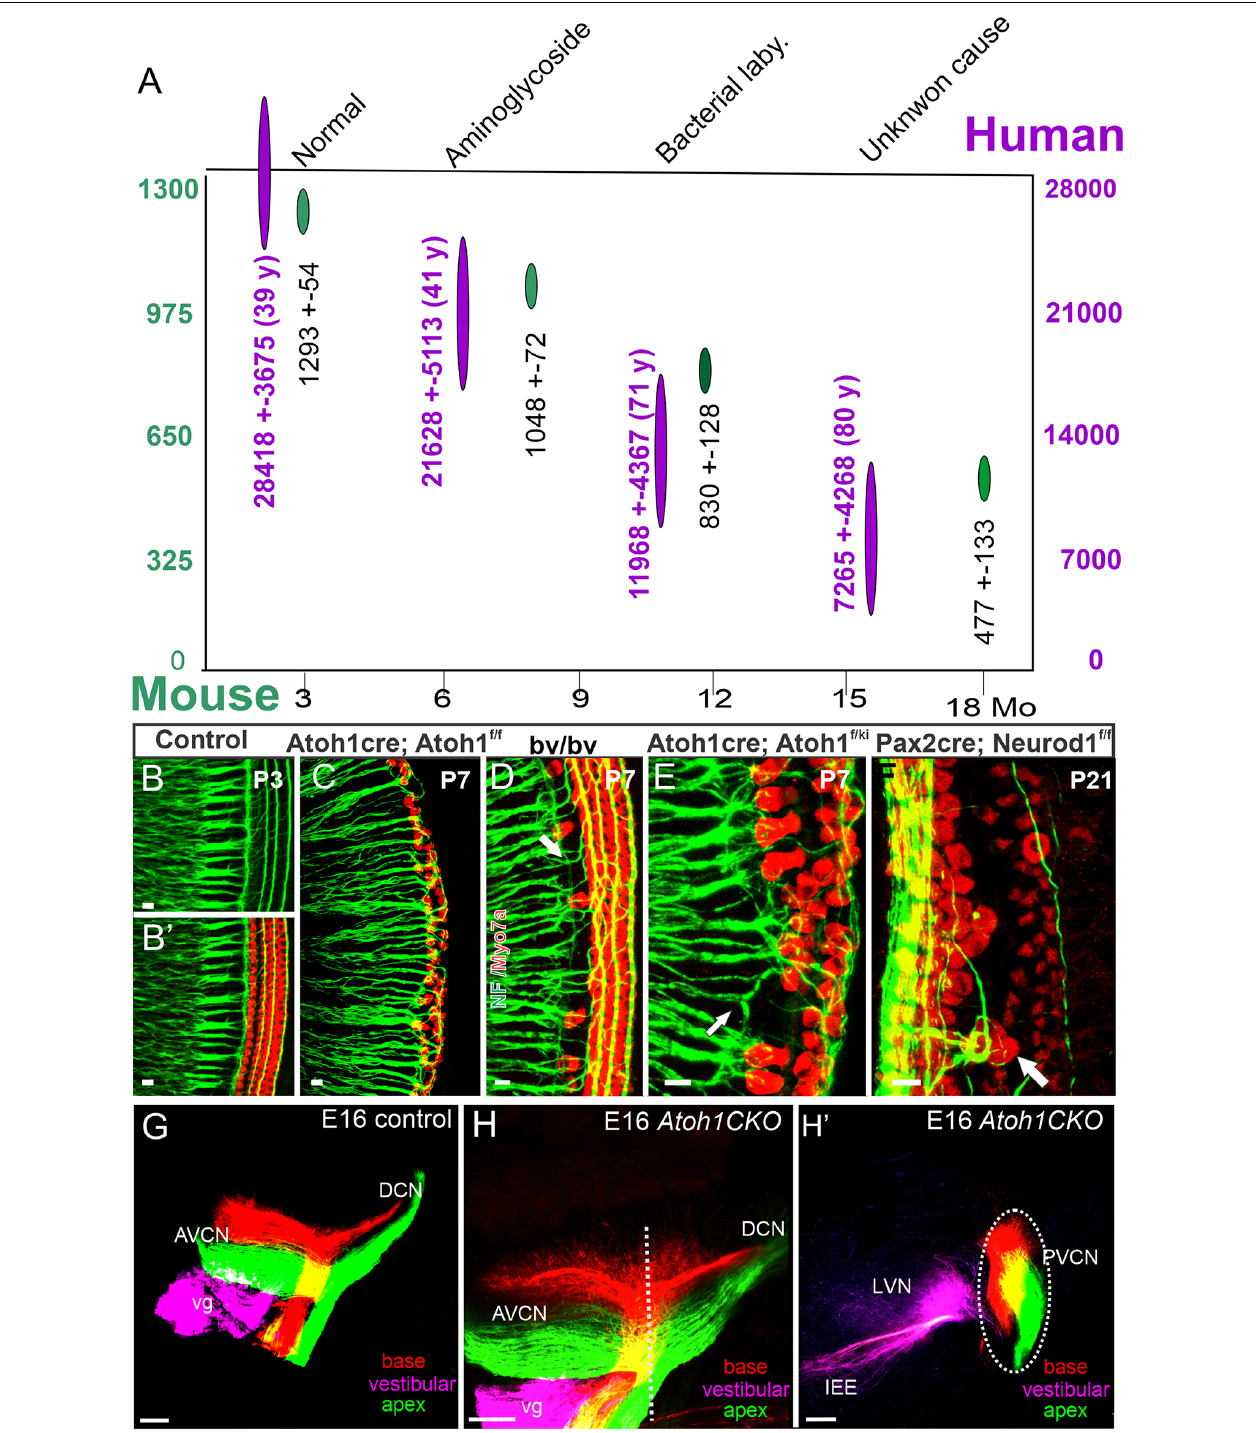
FIGURE 2 | A loss of neurons with time reduces the ∼ 28,000 SGNs in ∼ 40-year-old humans to ∼ 25% in 80-year-old humans ( A , purple). A similar loss is shown for ∼ 1,300 SGNs and reduces to ∼ 40 in 18 month-old mice ( A , green). Immunoreaction of labeling for neuron markers validates the inner ear afferents in control mice (B,B’) . This is compared with Atoh-cre;Atoh1 f/f ‘self-termination mice (C) , Bronx waltzer ( bv/bv ) (D) , Atoh-cre;Atoh1 ki/f (E) , and Pax2-cre; Neurod1 (F) . Central projections reach the anterior (AVCN) and dorsal (DCN) cochlear compared to controls (G) and Atoh 1 C KO mice (H) that show a tonotopic organization of SGN central projection, despite the absence of cochlear hair cells (H’) —modified after Nadol Jr (1990), White et al. (2000), Jahan et al. (2018), and Filova et al. (2020). Scale bars: 10 µ m (B–F) and 100 µ m (G–H) .